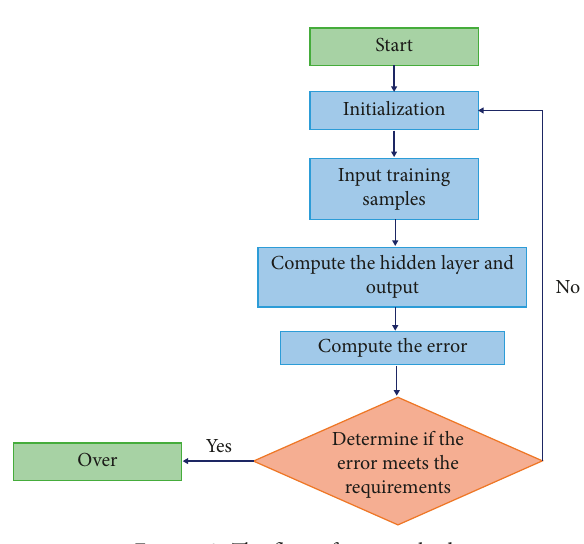
Figure 3: The flow of our method. Table 1: Tourism resource evaluation index